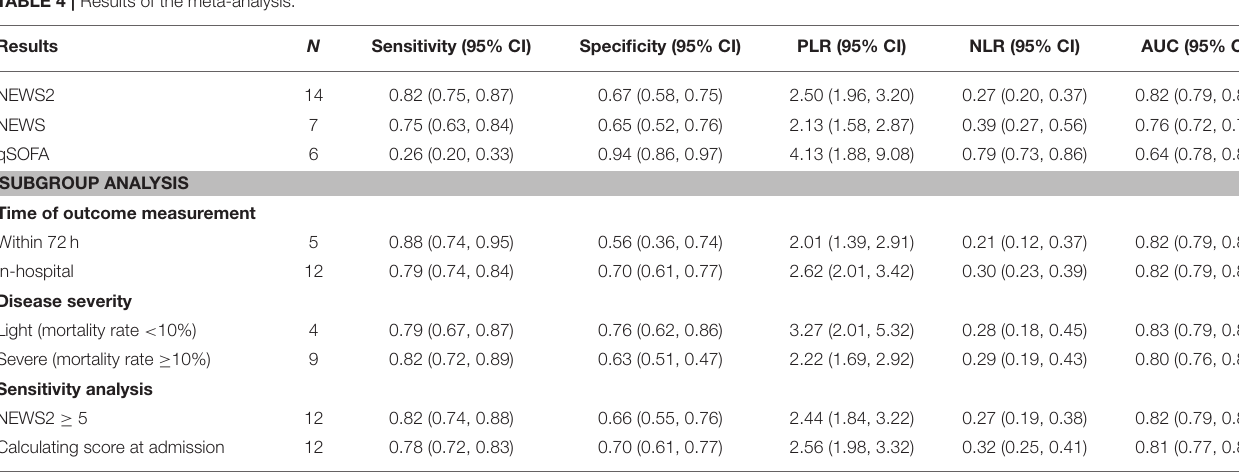
TABLE 4 | Results of the